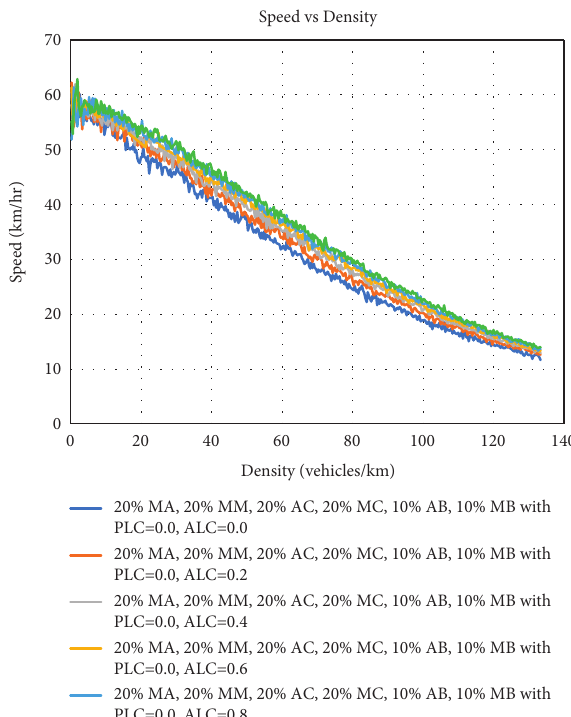
Figure 5: Flow rate vs. density fundamental diagrams for different compositions of MA, MM, AC, MC, AB, and MB with different values of ALC when PLC is fixed at 0.